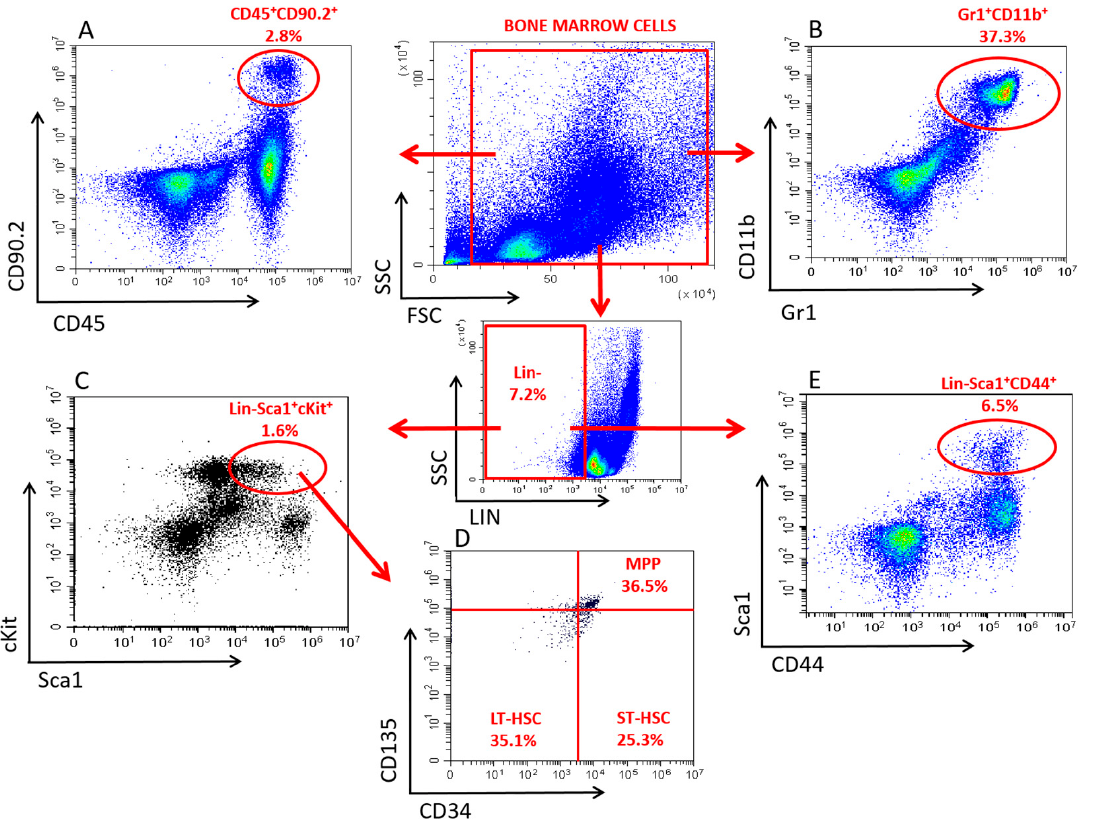
Figure 1. Gating Strategy for the Identification of Different Bone Marrow Cell Populations by Flow Cytometry. ( A ) Lymphoid progenitor cells were identified as CD45 and CD90.2 double positive cells in bone marrow cells. ( B ) Granulocytes/monocytes were characterized as Gr1 and CD11b double positive cells in bone marrow cells. ( C ) Hematopoietic stem and progenitor cells were identified as Sca1 and cKit double positive cells in the Lineage negative bone marrow cells. ( D ) Hematopoietic stem cell subpopulation characterization was done by using the CD34 and CD135 markers in the hematopoietic stem and progenitor cell pool. Long-term hematopoietic stem cells were identified as CD34 and CD135 double negative cells, short-term hematopoietic stem cells were CD34+CD135- cells, multipotent progenitors were characterized as CD34 and CD135 double positive cells. ( E ) Mes- enchymal stem and stromal cells were identified as Sca1 and CD44 double positive cells in the lineage-negative bone marrow cells.